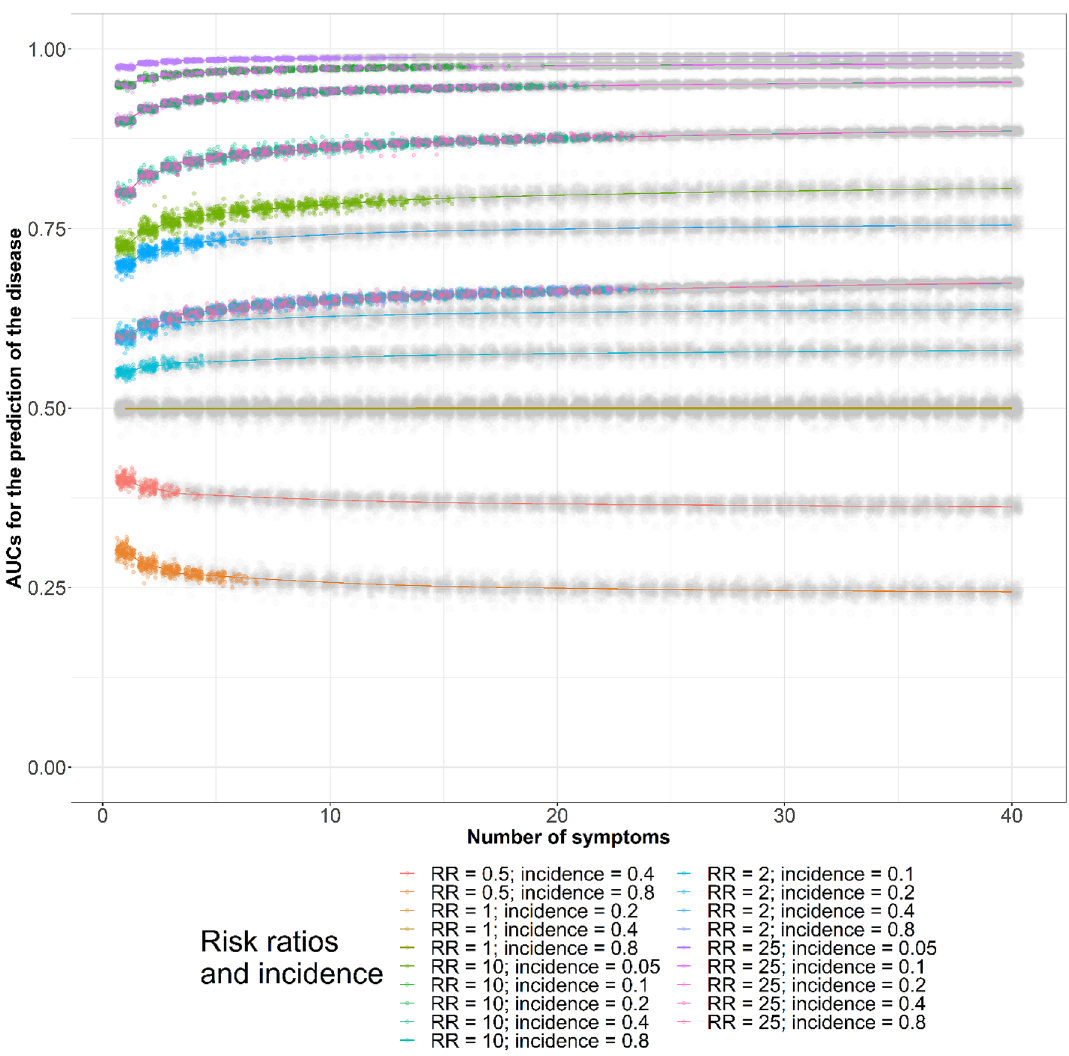
Figure 4. Areas under the receiver operating characteristic curves for disease diagnosis by numbers of symptoms, baseline symptom incidence, and symptom risk ratios. AUC area under curve, CI confidence interval, RR risk ratio, incidence baseline symptom incidence among those not diseased. Gray dots are the area under curve (AUCs) whose 95% confidence intervals (CIs) overlapped with the maximal AUC 95% CIs identified using a maximum of 40 symptoms for disease diagnosis. The lines were added to show the AUCs assuming the same epidemiological measures. All AUCs assuming 0.8 correlations between symptoms among those not diseased are